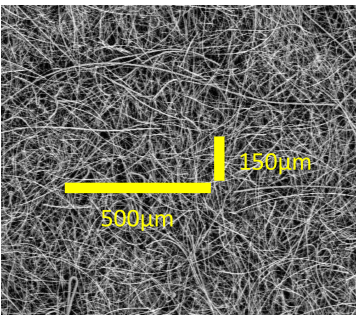
Figure 2. Electron microscope image of a blank quartz-fiber filter used in this